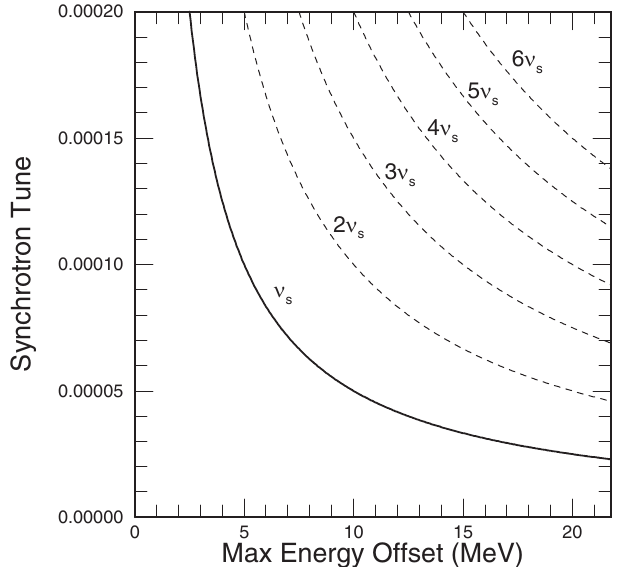
FIG. 1. Synchrotron tune as functions of energy offset, when the barrier separation is T and the barrier voltage V higher synchrotron harmonics.*Electronic address: